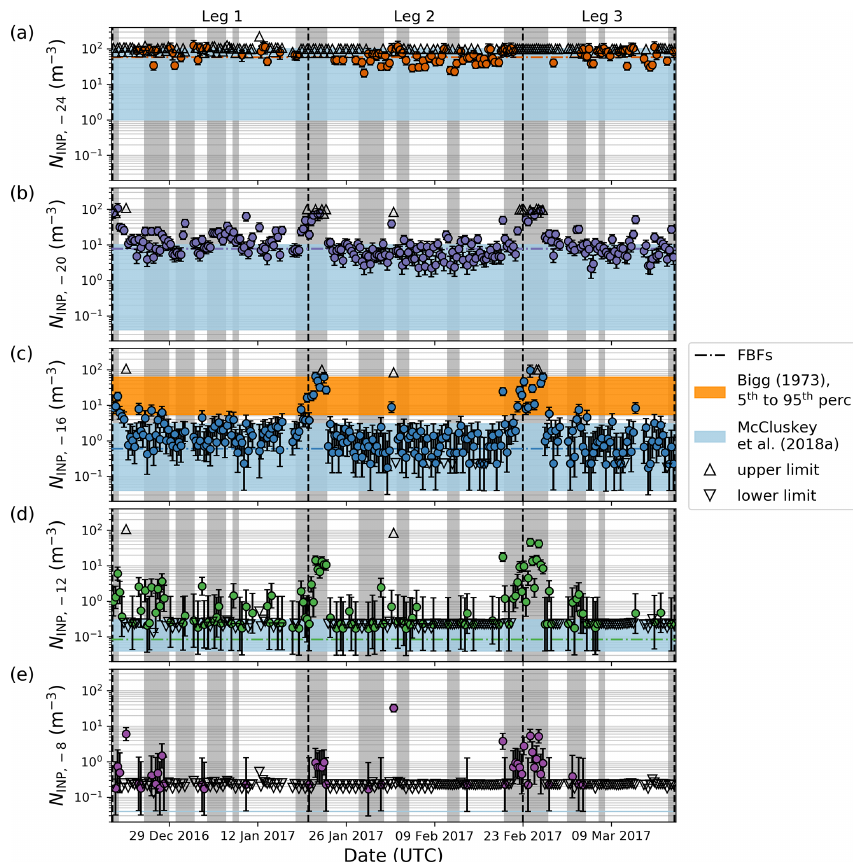
Figure 5. Time series of INP number concentration ( N INP ) at (a) − 24, (b) − 20, (c) − 16, (d) − 12, and (e) − 8 ◦ C from the LV filters sampled during ACE. N INP values outside the detectable range are indicated by downward (upward) pointing triangles if they are below (above) the lower (upper) edge of the detectable range. The legs of ACE (dashed lines) and periods when the RV was close to land (grey area) are indicated. In (a)–(d) the measurement background from averaged spectra of field blank filters (FBFs) is indicated (dashed–dotted lines). N INP values from McCluskey et al. (2018a) are included for reference (blue area). In addition, N INP , − 15 values from Bigg (1973) are included in (c) as the range between their 5th and 95th percentile (orange area). A correction of the N INP , − 15 values from Bigg (1973) was applied, following the supporting information to McCluskey et al.